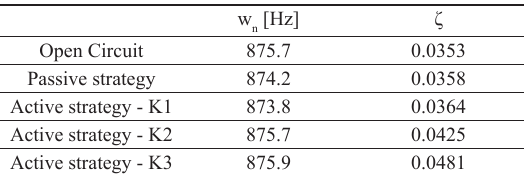
Figure 10. Experimental FRF amplitude with parallel multilayer piezoelectric actuator for second Table 1. Polynomial multi-mode system identification parameters for the 1 st configuration.